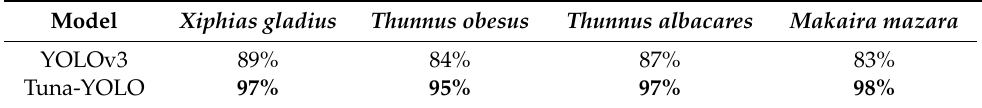
Table 7. Precision values of tunas on Tuna-YOLO and original